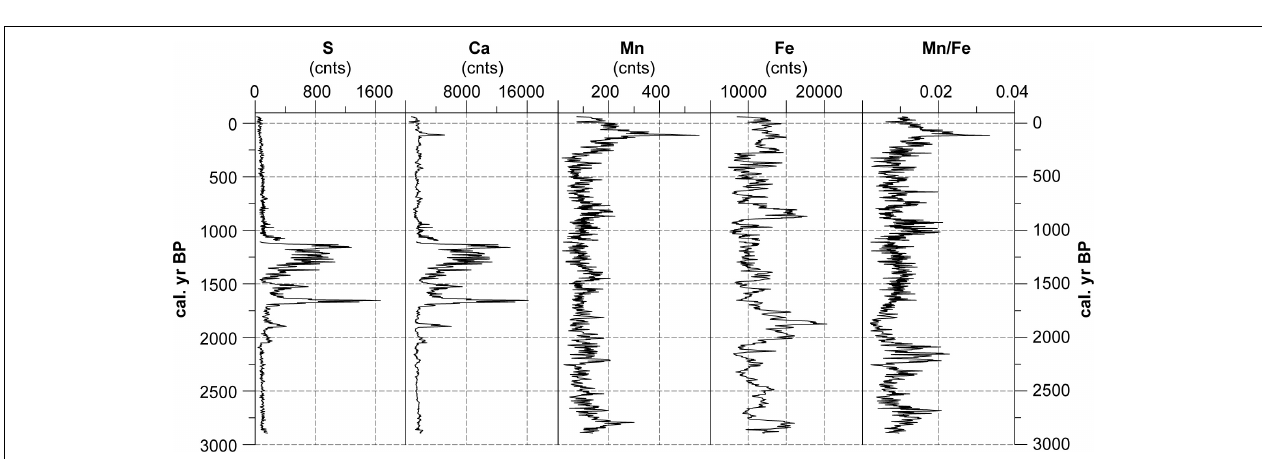
FIGURE 5 | Stable oxygen and carbon isotope composition of cellulose. Given are δ 18 O cell (% vs. VSMOW) and δ 13 C cell (% vs. VPDB) for the respective fractions < 200 µ m, 200–1000 µ m and > 1000 µ m. Missing values are due to insufficient cellulose material for analyses and the hiatus between 1080 and 1110 cal. yr BP.